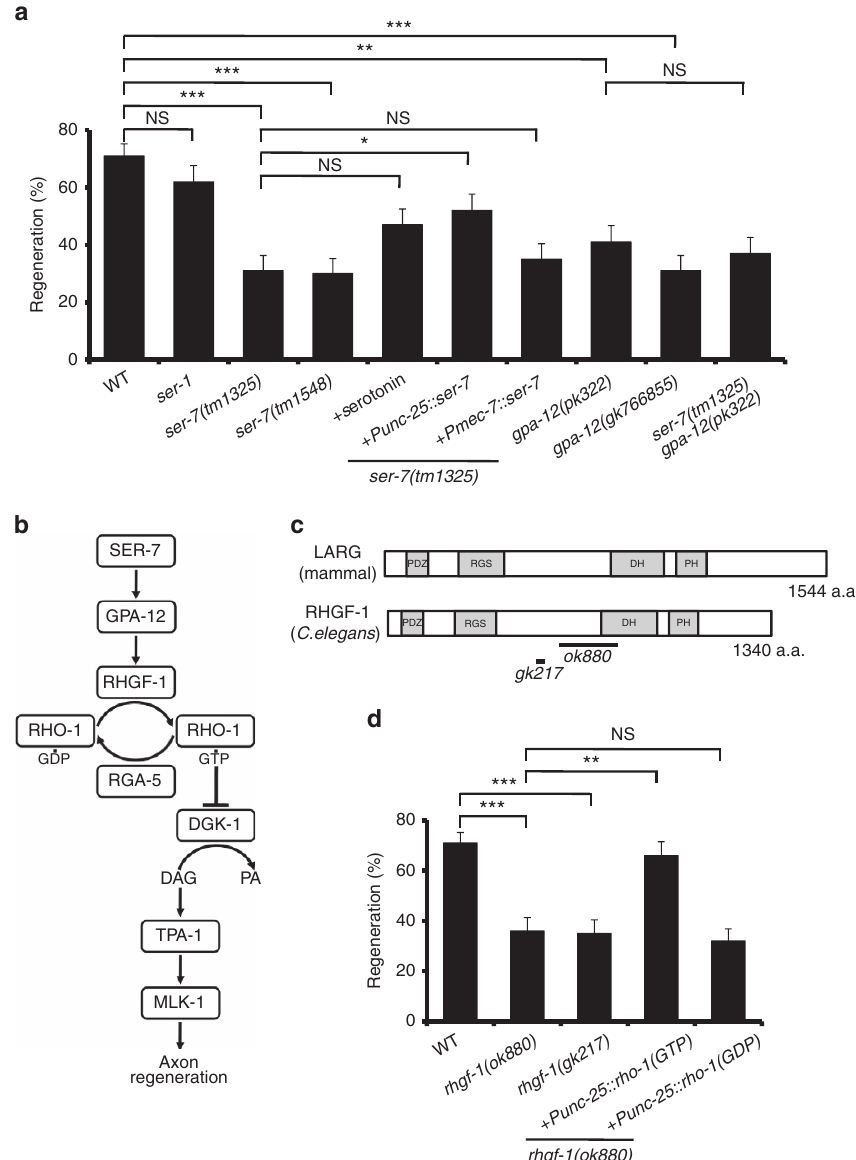
Figure 3 | 5-HT-SER-7 signalling activates axon regeneration via GPA-12 and RHGF-1. ( a , d ) Percentages of axons that initiated regeneration 24h after laser surgery. Error bars indicate 95% CI. *** P o 0.001; ** P o 0.01; * P o 0.05; NS, not significant (Fisher’s exact test, two-tailed, n Z 50). ( b ) SER-7 signalling pathway. SER-7 activates the GPA-12-RHGF-1-RHO-1 pathway. Activation of RHO-1 inhibits DGK-1, leading to a stabilization of DAG levels. ( c ) Structure of RHGF-1. Schematic diagrams of RHGF-1 and its human counterpart are shown. Domains are shown as follows: a PDZ domain, a regulator of G protein signalling domain (RGS), a Dbl homology domain (DH) and a Pleckstrin homology domain (PH). The bold lines underneath indicate the extent of the deleted regions in the rhgf-1(ok880) and rhgf-1(gk217) mutants. NATURE COMMUNICATIONS|7:10388|DOI: